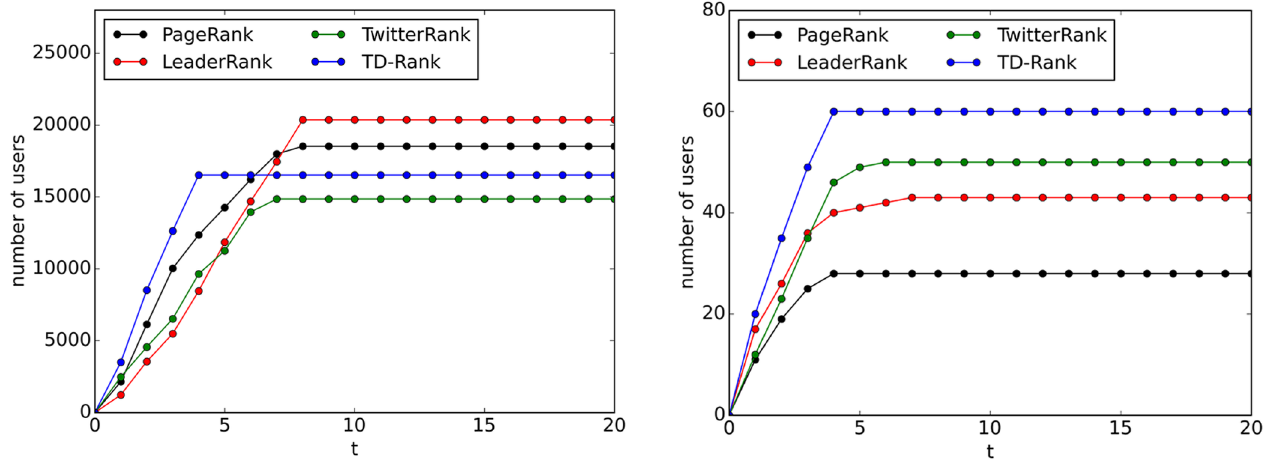
Fig 5. Comparison of influence maximization. (a) The results of IC Model. (b) The results of TIC Model.